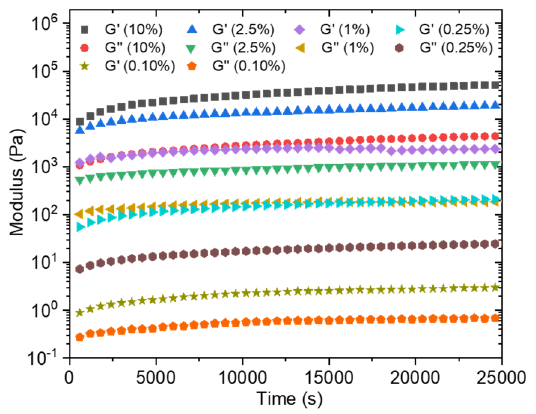
Figure 7. Storage (G’) and loss (G’’) modulus of C 16 V 3 A 3 K 3 G-NH 2 –PSSNa in water as a function of time at different solid concentrations (frequency = 10 rad/s; strain = 0.1%; R +/ − = 1).